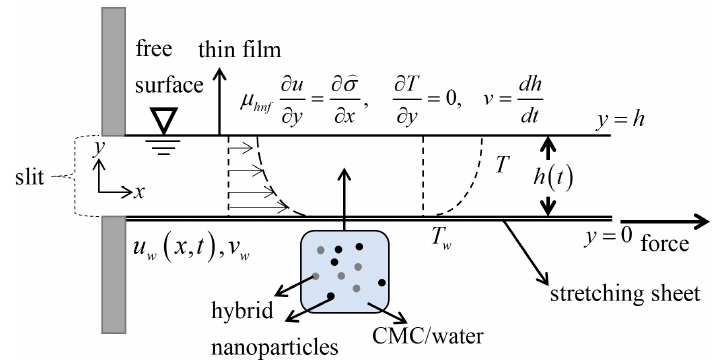
Figure 1. Visual representation of the present flow problem over a stretching sheet.